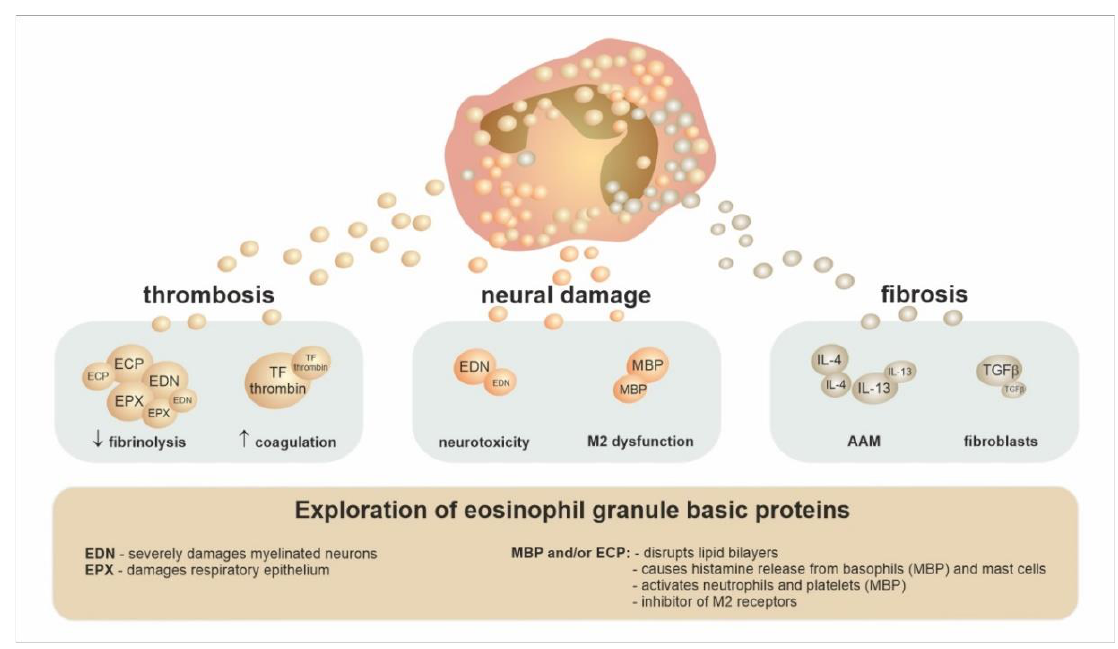
Figure 5. Role of eosinophils in the tissue pathology. The eosinophil infiltration of tissues during various eosinophil-associated diseases is inherently associated with the detrimental effect of the abundant production of several proteins and cytokines. These molecules are subsequently responsible for activating hemostasis (by the damping fibrinolysis and strengthening coagulation) and creating thrombi concurrently with neural damage and fibroproduction. All of these processes are included in the complex tissue pathology. Abbreviations: MBP—major basic protein, EPX—eosinophil peroxidase, ECP—eosinophil cationic protein, EDN—eosinophil-derived neurotoxin, TF—tissue factor,